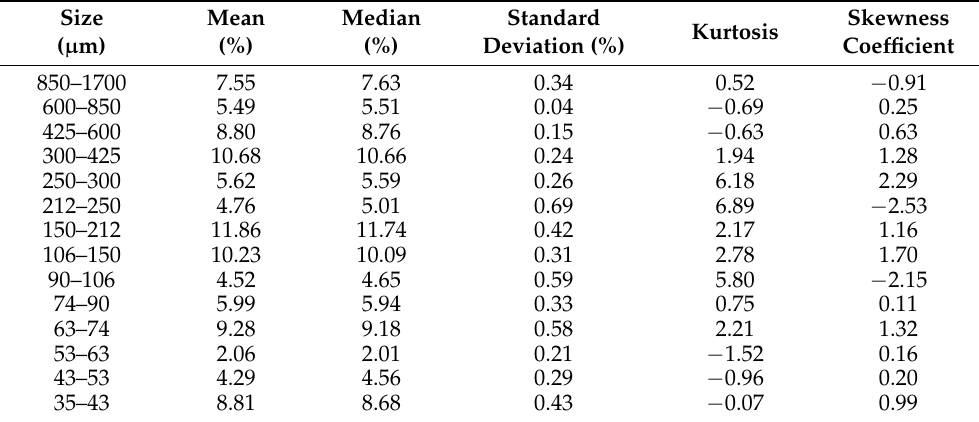
Table A6. Descriptive statistics of the 8 min test for the partial detainees with 95% confidence interval.